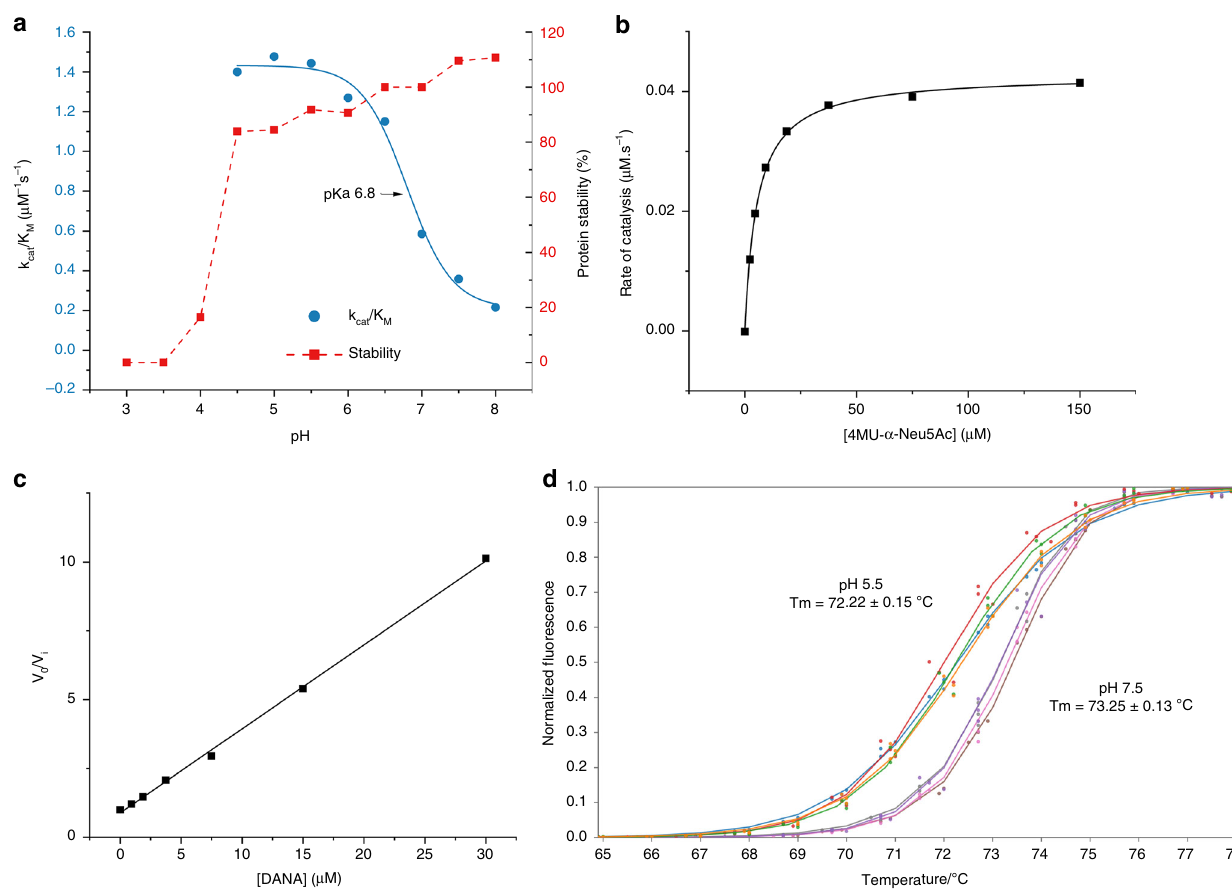
Fig. 1 EnvSia156 activity and stability. a pH dependence of EnvSia156 using 4MU- α -Neu5Ac as substrate to monitor hydrolysis. Red squares show relative enzyme activity after incubation at different pH. Enzyme activity was assayed at pH 5.5 after preincubating EnvSia156 for 30 min at the several pH values. The rate obtained is shown as a percentage of the rate obtained at pH 7. EnvSia156 is unstable below pH 4 over the time period tested. Blue circles show the k cat / K M measured at each pH by the substrate depletion method. The pro fi le shows an optimal pH for hydrolysis of 5 with a p K a of 6.8. Experiments were performed in triplicate. b Michaelis – Menten plot of 4MU- α -Neu5Ac hydrolysis by EnvSia156. Rate of catalysis was determined in triplicate for each 4MU- α -Neu5Ac concentration. c Plot of EnvSia156 V 0 / V i against inhibitor concentration [DANA]. Reaction rate was determined by measuring the release of 4-methylumbelliferone (4MU) in the absence ( V 0 ) and presence ( V i ) of inhibitor. The 1/ K i value was derived from the slope of the best fi t line. Experiments were performed in triplicate. d DSF curve of EnvSia156 (12.5, 25, 50, and 100 nM) at pH 5.5 and 7.5. Fluorescence measurements